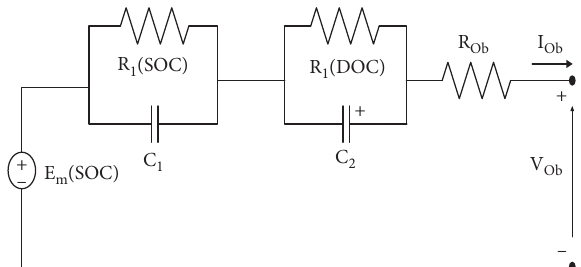
Figure 12: Simple lead-acid battery topology.